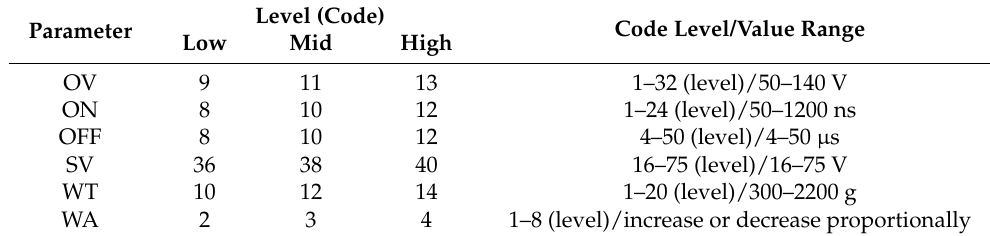
Table 1. Machining parameters with three levels.